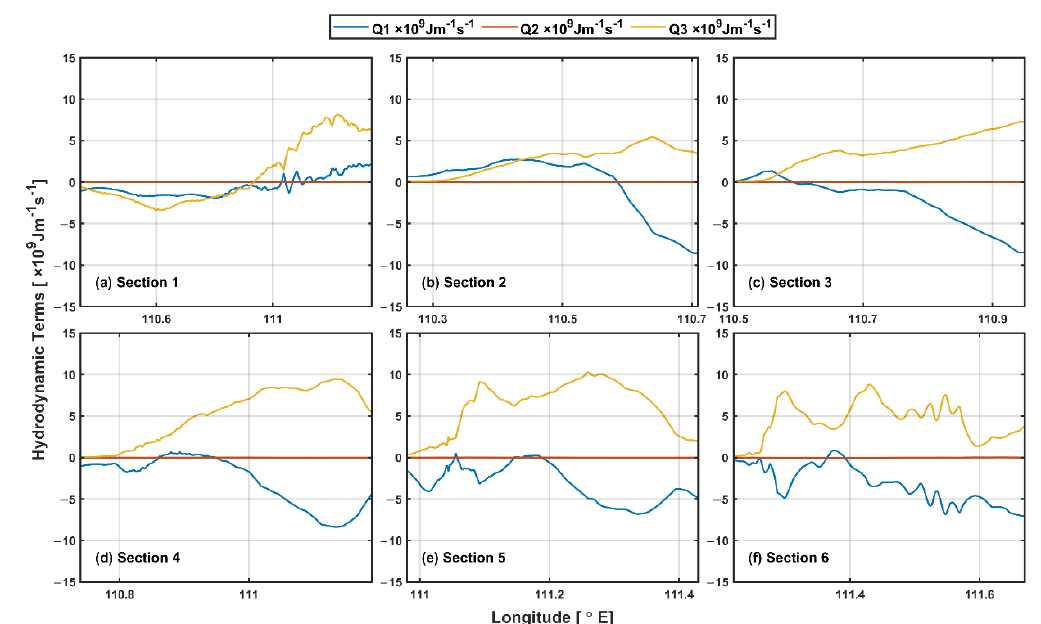
Figure 12. The contribution of different hydrodynamic terms to the heat flux in in Sections 1 – 6 of Figure 1c. In Section 1, positive (negative) values indicate upslope (downslope) heat transport. In Sections 2 – 6, positive (negative) values imply northeastward (southwestward) heat transport.